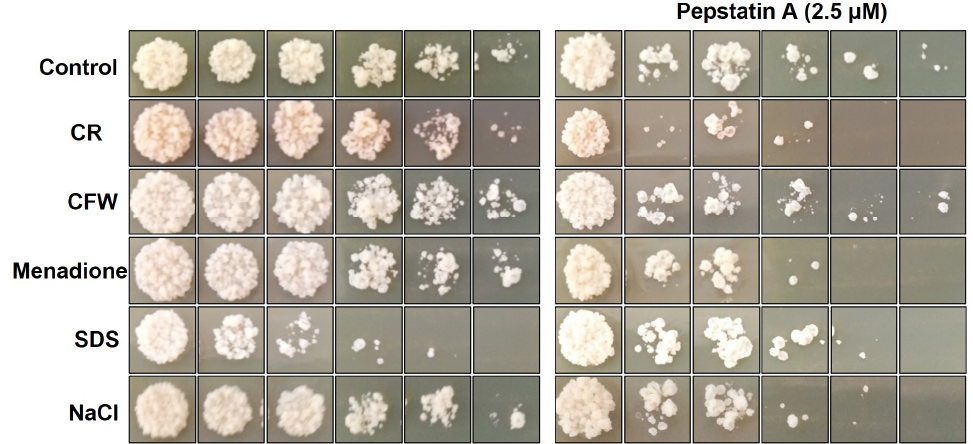
Figure 5. Aspartic proteases modulated the growth of Paracoccidioides brasiliensis cultivated in the presence of different stressors. P. brasiliensis yeast cells (1 × 10 6 cells) were diluted, plated in a solid mYPD medium containing different agents that disturb the cell wall, oxidative stress, and osmotic stress, such as Calco fl uor White (CFW—1 µg/mL), Congo Red (CR—2 µg/mL), Sodium dodecyl sulphate (SDS—0.001%), Menadione (10 µM), and NaCl (150 mM) in the presence or absence of Pepstatina A (2.5 µM). Finally, cells were incubated for seven days at 37 °C. The results shown are representative of three independent experiments.